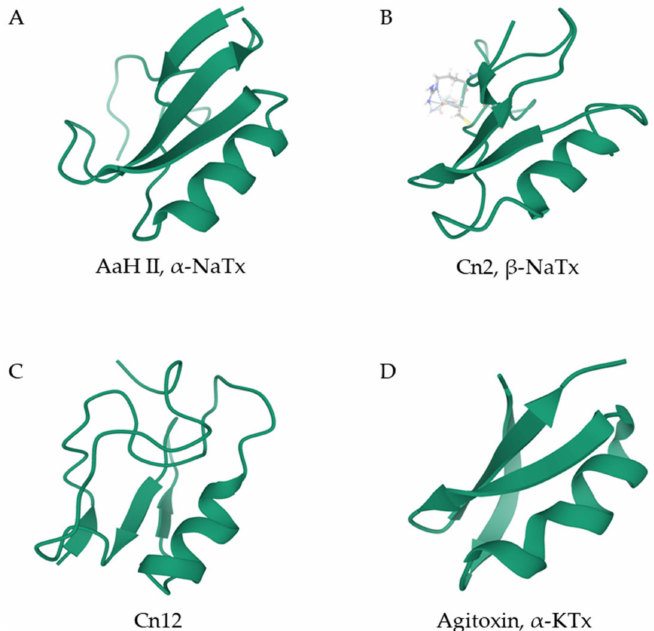
Figure 1. Ribbon diagrams of the 3D structure of selected scorpion venom peptides containing the cysteine-stabilized (CS) α / β motif. ( A ) AaHII from Androctonus australis is a classical α -NaTx. ( B ) Cn2 from Centruroides noxius venom is a classical β -NaTx. ( C ) Cn12, also from C. noxius venom, shows structural resemblance to β -NaTxs, but exhibits an α -NaTx function. ( D ) Agitoxin 1 from Leiurus hebraeus (previously L. quinquestriatus hebraeus ) is an α -KTx toxin. The Protein Database accession numbers are 1PTX for AhHII; 1CN2 for Cn2, 1PE4 for Cn12, and 1AGT for agitoxin 1. KTx: potassium channel toxins, NaTx: sodium channel